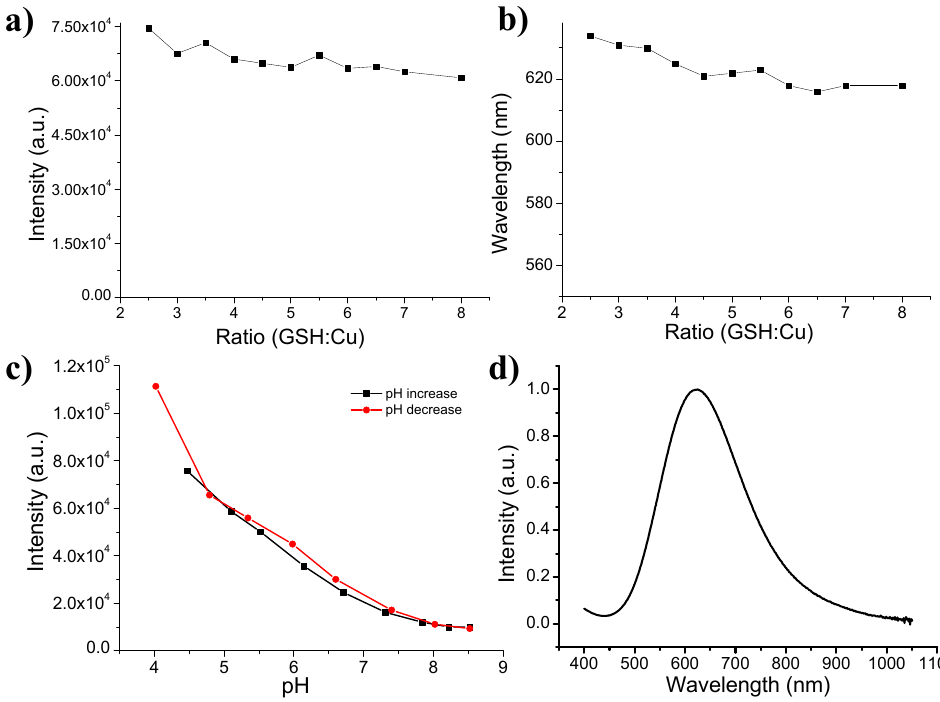
Figure 3. ( a ) Fluorescence intensity and ( b ) emission wavelength of Cu(I)-GSH complex at different R GSH/Cu ; ( c ) Fluorescence intensity of Cu(I)-GSH complex (Cu/GSH = 1:4 mol/mol) at different pH values; ( d ) Absorption spectrum of non-luminescent Cu(II)-GSSG complex.